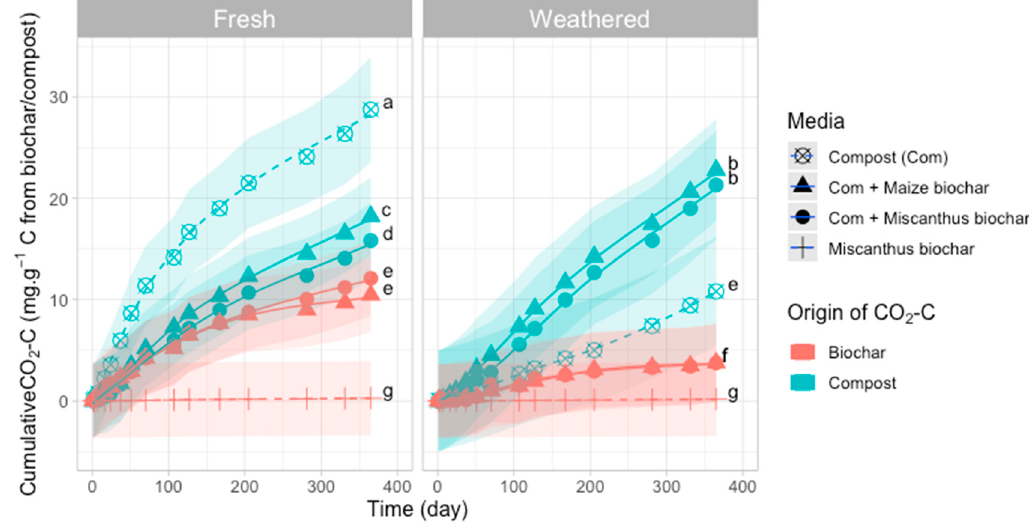
Figure 2. Cumulative CO 2 -C mineralized from biochar and compost when incubated alone or in mixture. Turquoise and red colors represent C mineralized from compost and biochar respectively. Data represent means from 3 replicated samples. The colored ribbon represents the standard deviations. The letters represent the significant differences from a two-ways ANOVA analysis ( n = 3).